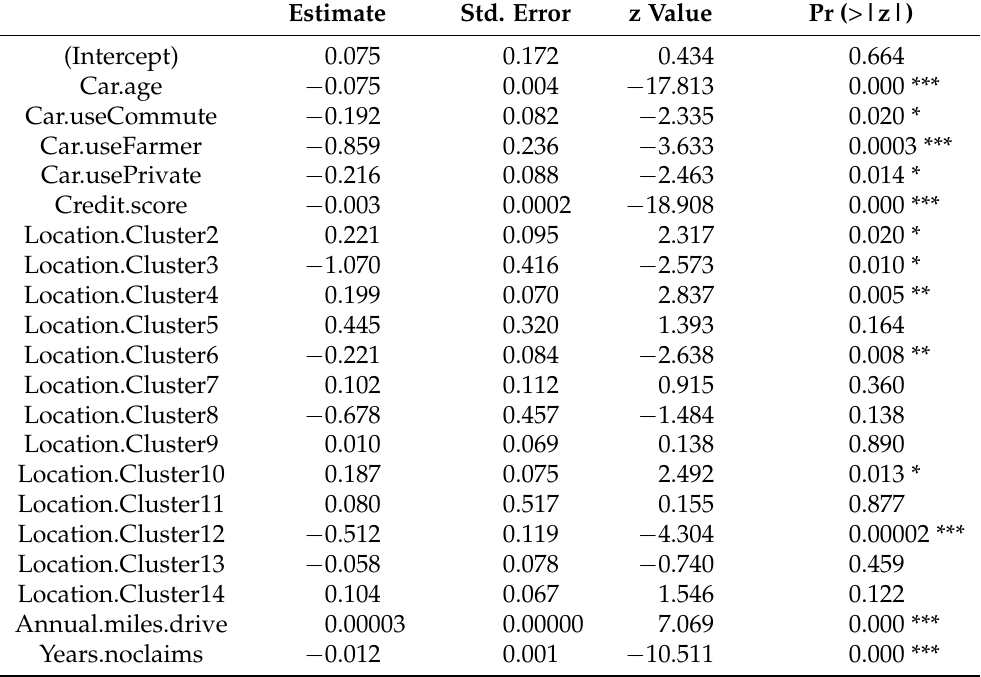
Table 3. The model outputs from Logistic Regression (with designed clusters) used to predict claim